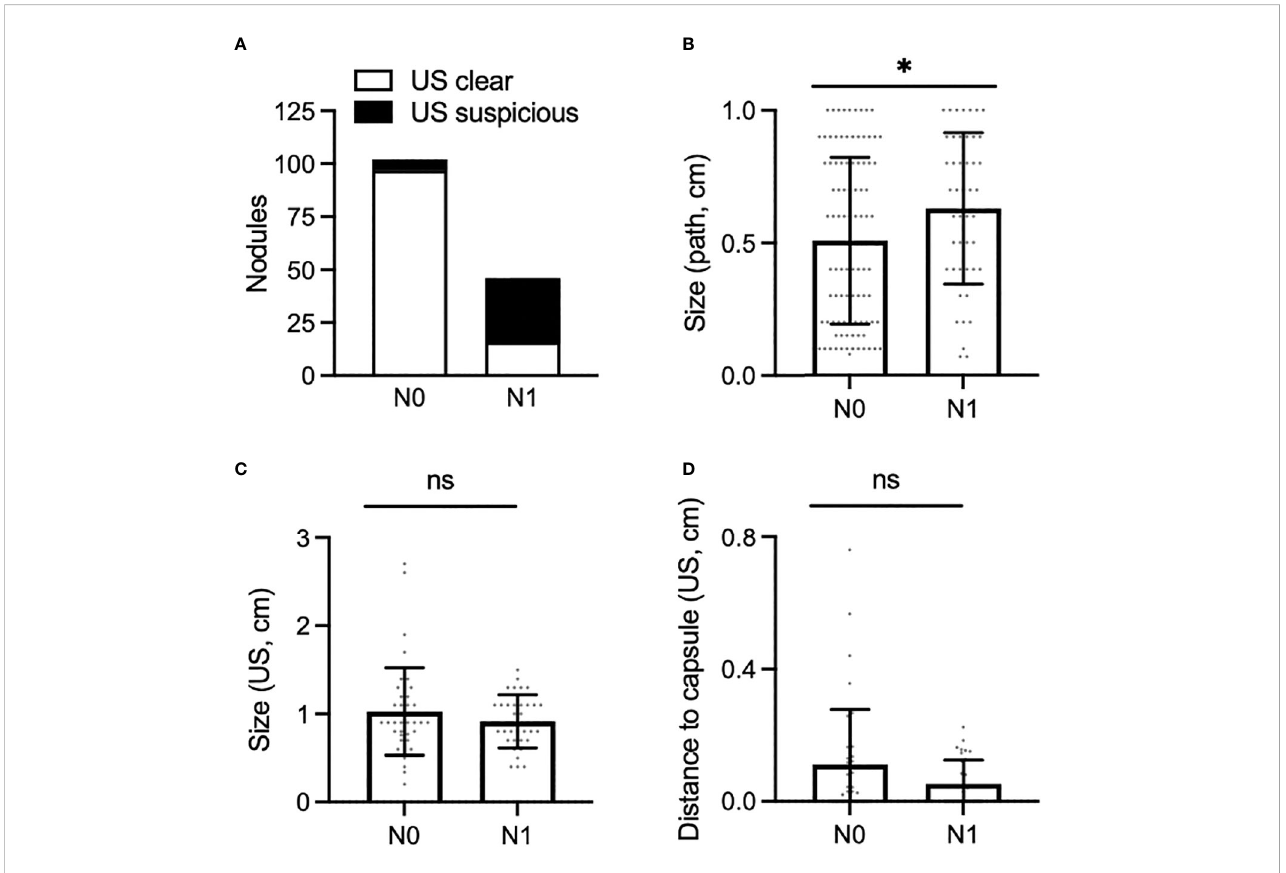
FIGURE 3 (A) Proportion of PTMC nodules associated with N0 neck (left) and N1 neck (right), for which the preoperative ultrasound was clear of disease (white bar) or was suspicious for pathologic nodes (black bar). (B,C) Size of PTMC nodules associated with N0 or N1 disease as measured on surgical pathology (B) and preoperative ultrasound (C) . (D) , Shortest distance to the anterior or posterior thyroid capsule as measured on preoperative ultrasound in PTMC nodules associated with N0 or N1 disease. *, p < 0.05. ns, not stastistically signi fi